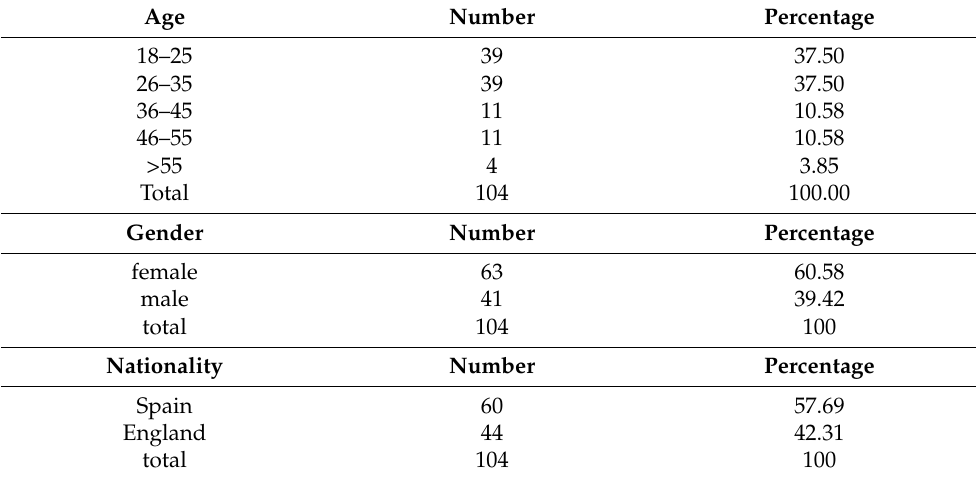
Table 2. Demographic characteristics of the participants.